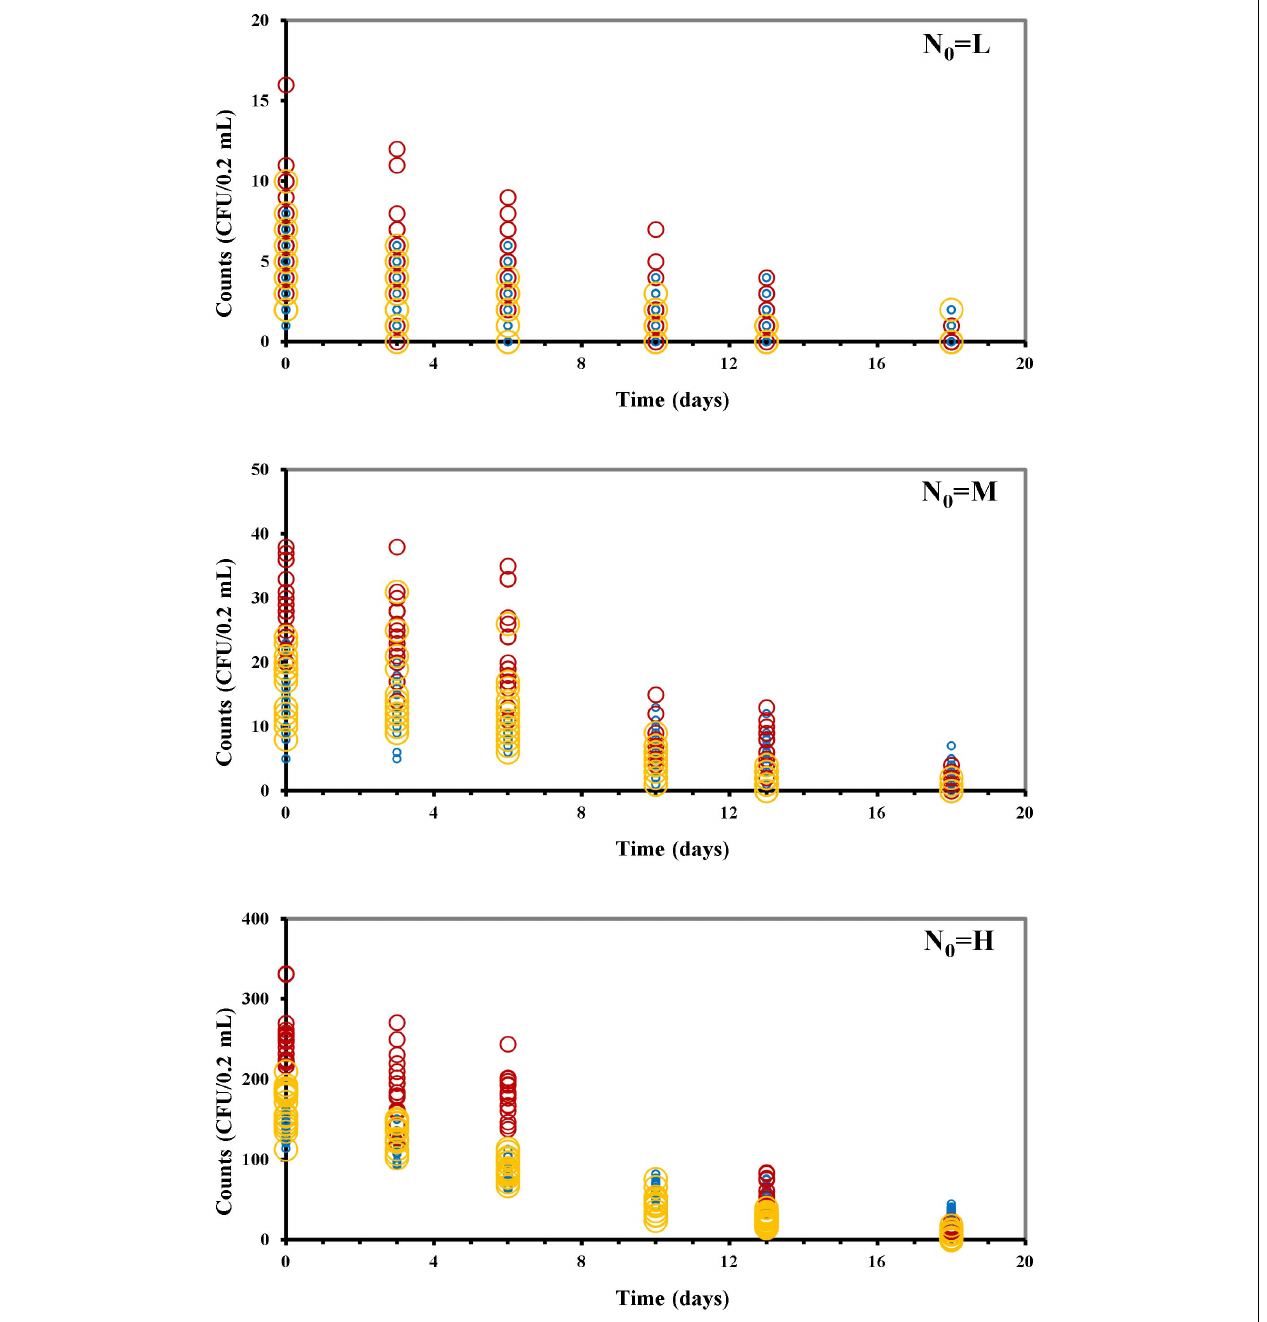
FIGURE 2 | Listeria monocytogenes survivors during the osmotic treatment, starting with different initial cells (N 0 : CFU/0.2 mL) (L, low inoculum; M, medium inoculum; H, high inoculum). Trial I, blue circles; trial II, red circles; trial III, yellow circles.